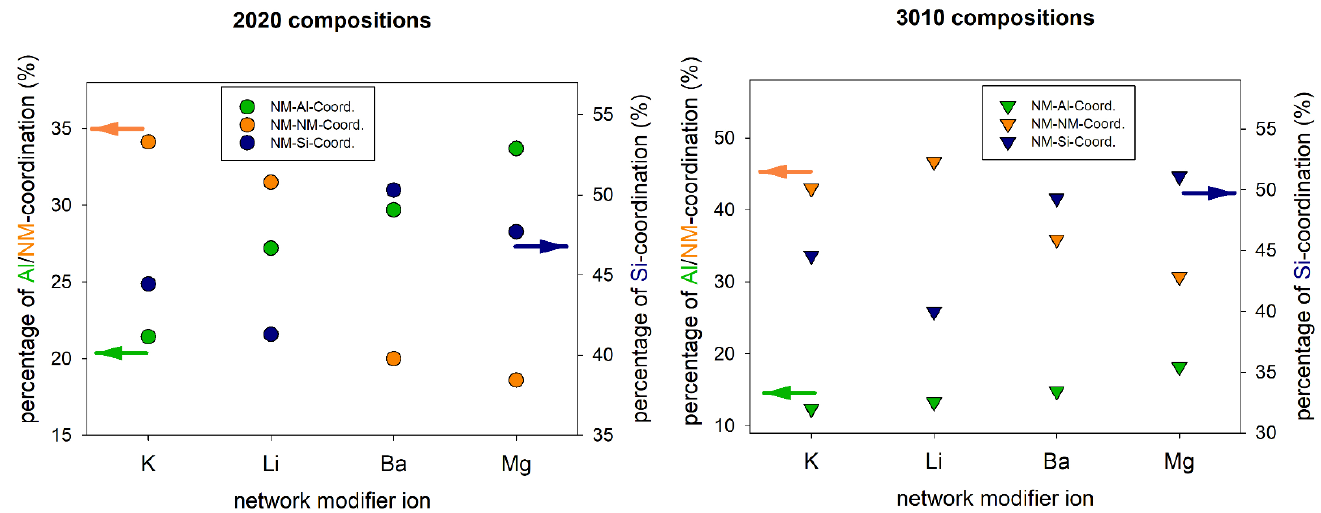
Figure 4. Network modifier-cation coordination fractions for metaluminous ( left ) and peralkaline ( right ) alkali and alkaline earth aluminosilicate glasses. Values for Ba and Mg-containing glasses are taken from [26].